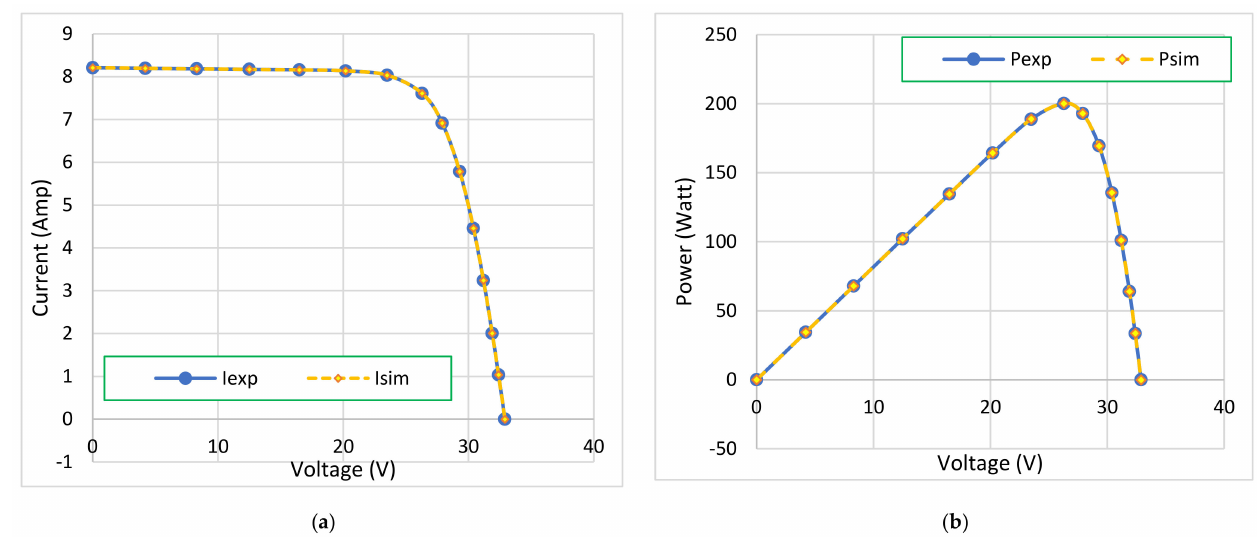
Figure 18. Characteristic curves for KC200GT SDM based on TFWO: ( a ) I–V ch/s and ( b ) P–V ch/s.